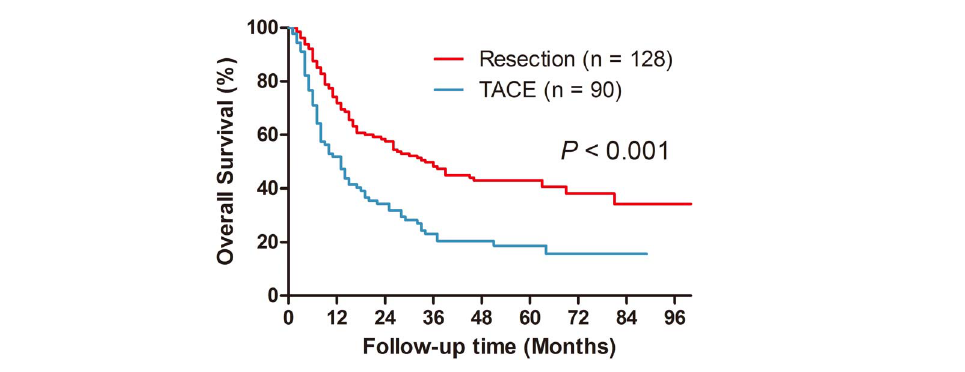
Fig. 1. Overall survival curves for the liver resection (LR) group and the transarterial chemoembolization (TACE)